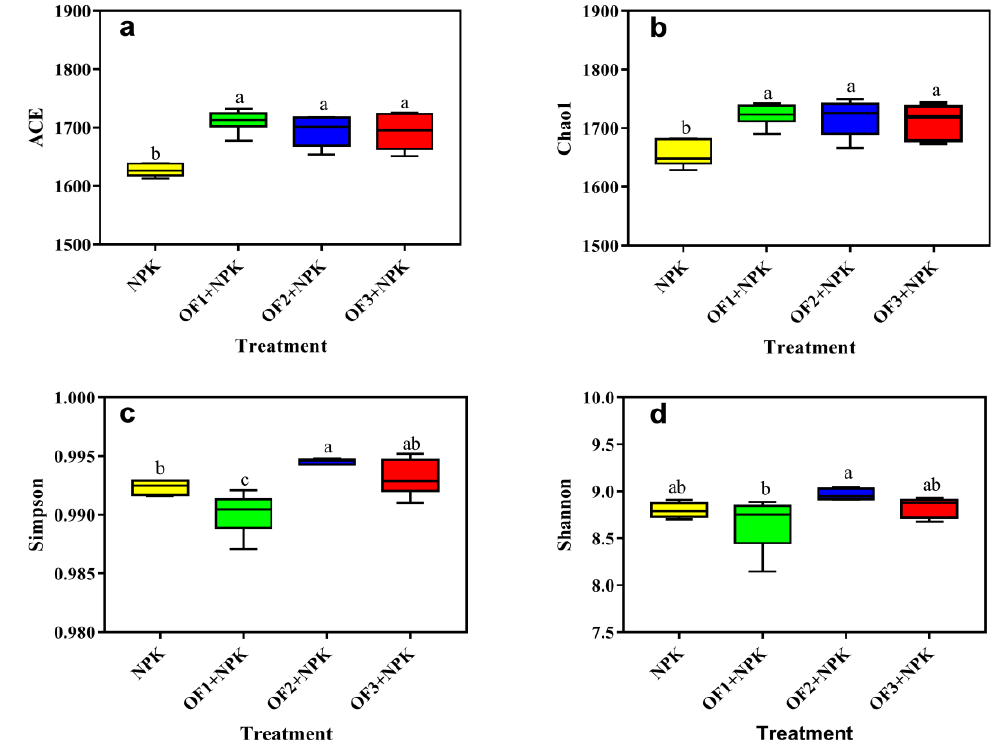
Figure 1. Effects of organic–inorganic fertilizers on soil bacterial diversity ( a ) ACE; ( b ) Chao1; ( c ) Simpson; ( d ) Shannon in a dry direct-seeded rice paddy soil. Different letters indicate significant differences ( p < 0.05). NPK, conventional fertilization; OF1 + NPK, seaweed bio-organic fertilizer and NPK; OF2 + NPK, Jishiwang bio-organic fertilizer and NPK; OF3 + NPK, attapulgite organic fertilizer and NPK .